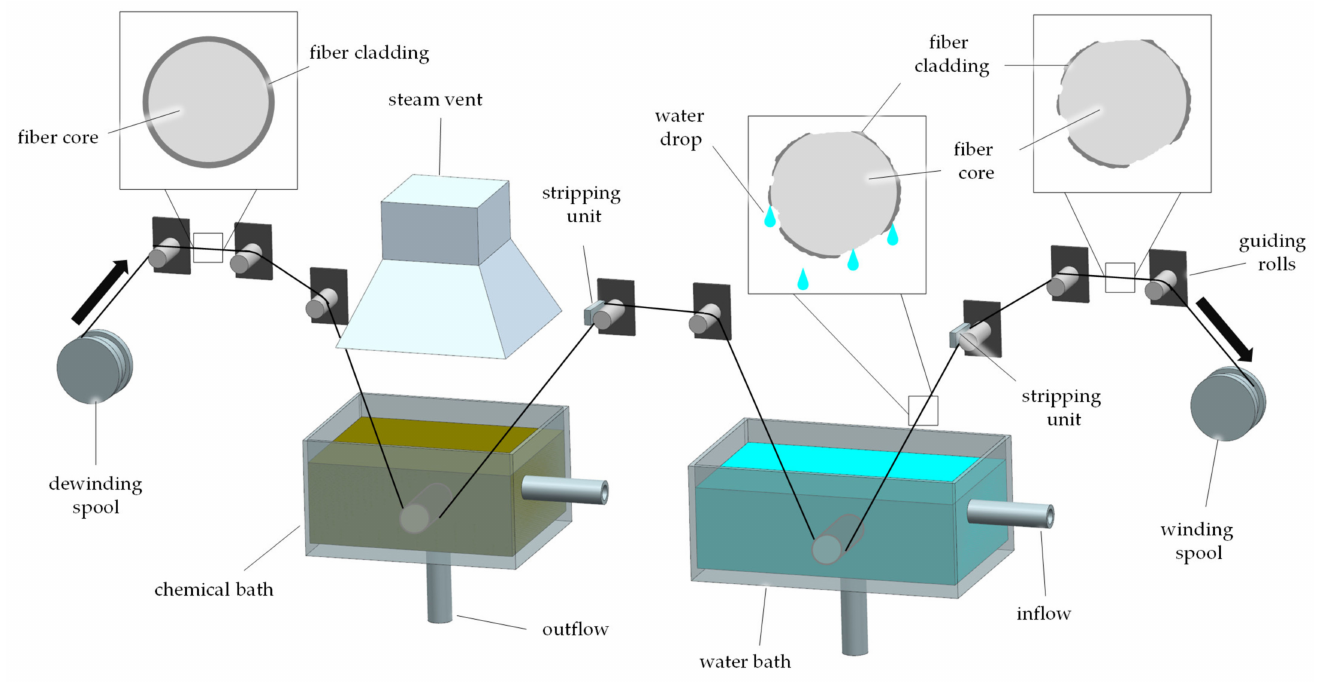
Figure 8. Process for chemical surface